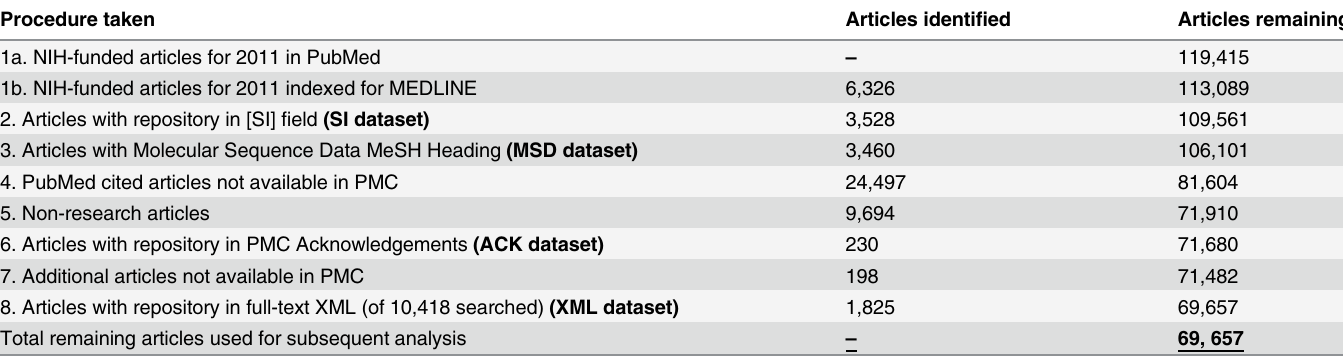
Table 6. Breakdown for subtraction of articles that mention the deposit of